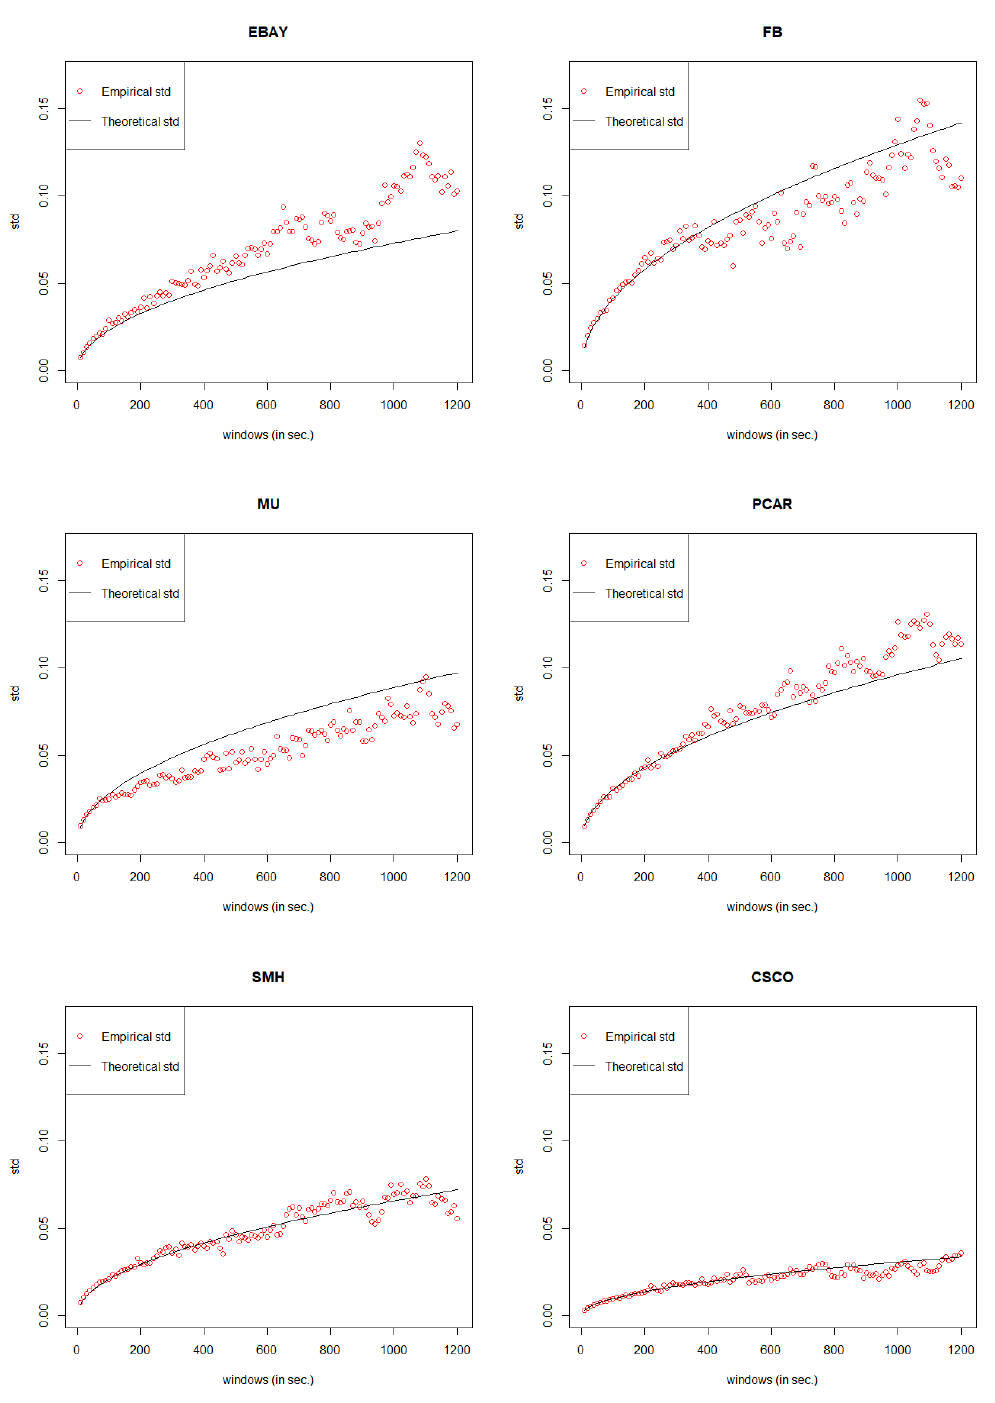
Figure 7. Best model fitting results for 6